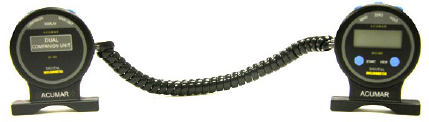
Figure 6. Acumar Dual Inclinometer device [29].